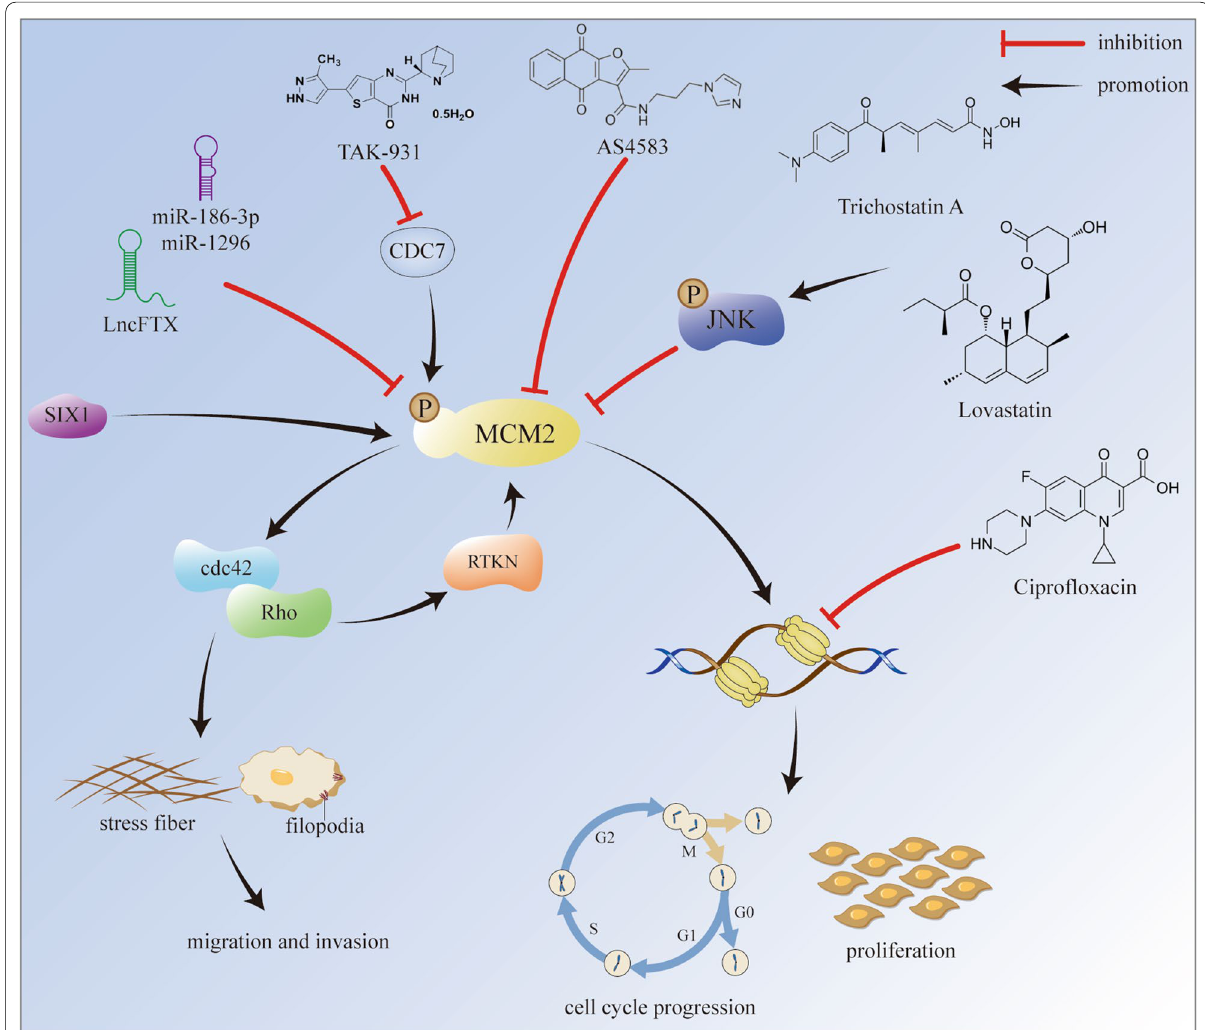
Fig. 3 Potential mechanisms of MCM2 in promoting cancer progression and existing inhibitors targeting